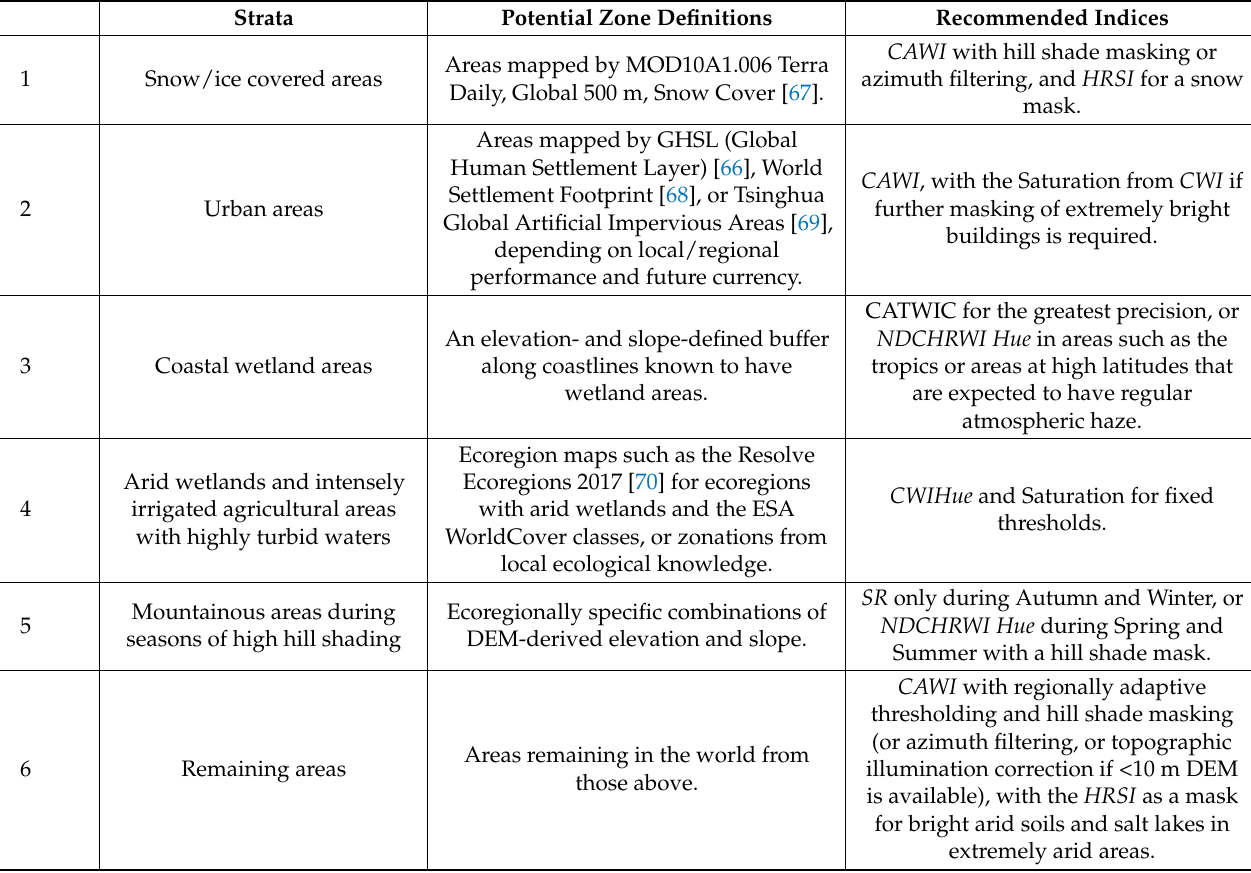
Table 11. Proposed global stratification for hydrologic satellite-based multispectral mapping and monitoring. Datasets to define the zones are listed if currently available on